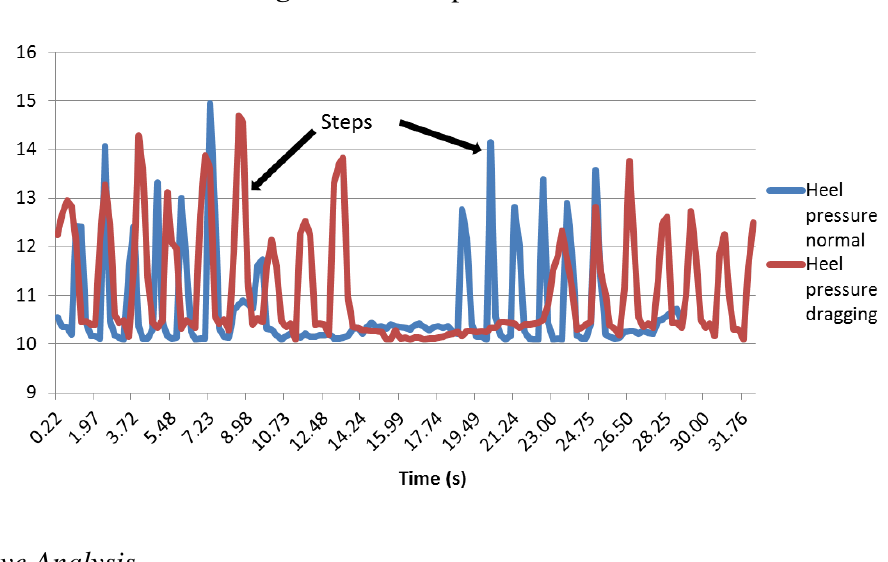
Figure 27. Heel pressure sensor.